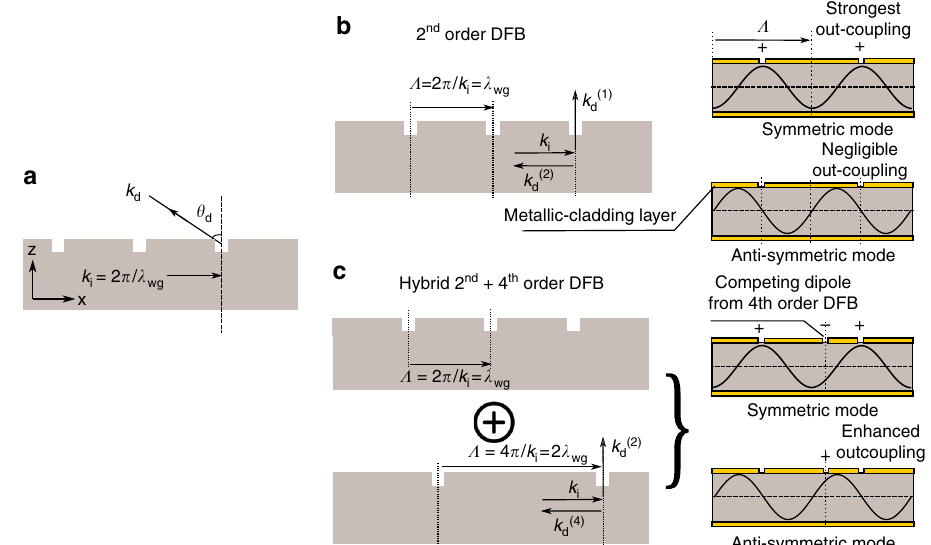
Fig. 1 The hybrid second-order and fourth-order grating scheme. a Schematic depicting Bragg diffraction due to periodic gratings in an optical waveguide. k i is the incident wavevector of the guided wave with a wavelength λ wg and k d is the wavevector of a diffracted wave, θ d is the angle of diffracted wave. b DFB Þ is in the surface-normal direction and second-order Bragg diffraction ð k ð 2 Þ Þ is in the due to second-order gratings, in which fi rst-order Bragg diffraction ð k ð 1 Þ d d opposite direction to the guided incident wave that establishes DFB. Symmetric (large radiative out-coupling) and antisymmetric (small radiative out- coupling) resonant modes are established at the edges of the photonic bandgap due to DFB. c A hybrid grating concept that combines second-order and fourth-order Bragg gratings. The second-order grating provides stronger DFB, and leads to establishing resonant optical modes with similar phase relationships to the grating as in b . An added fourth-order grating serves to enhance the out-coupling of the antisymmetric mode and reduce that of the symmetric mode. By adjusting design parameters, either of those modes could be excited in a DFB laser cavity that has a greater radiative ef fi ciency compared to the excited mode for a second-order DFB